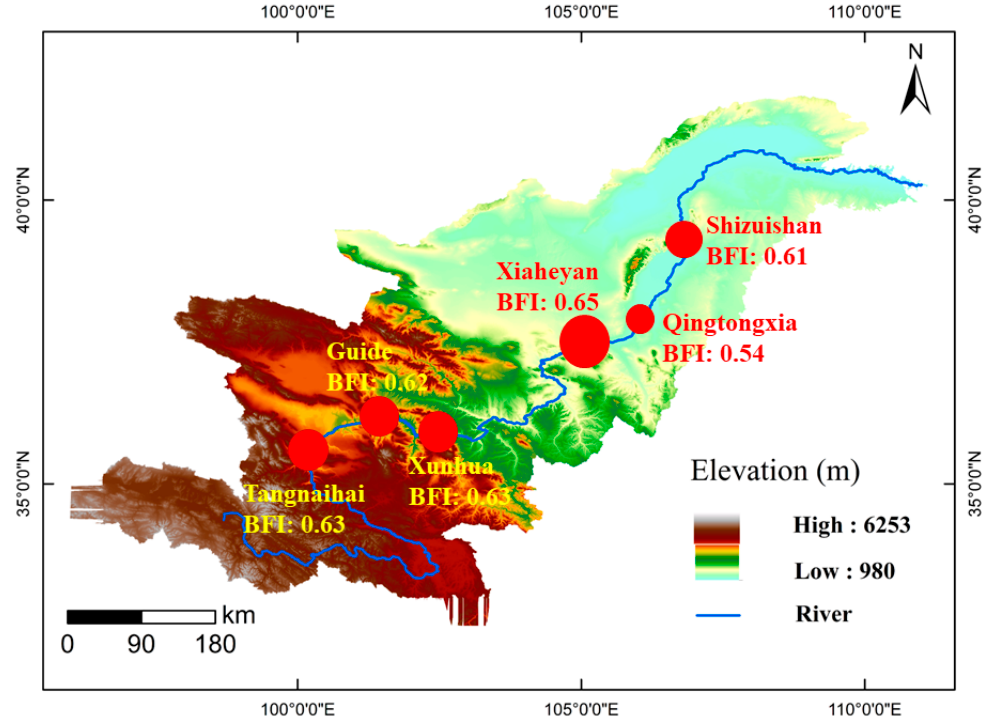
Figure 4. Spatial distribution in the calculated BFI in the upper reaches of the Yellow River. The bigger the circle, the larger its value.